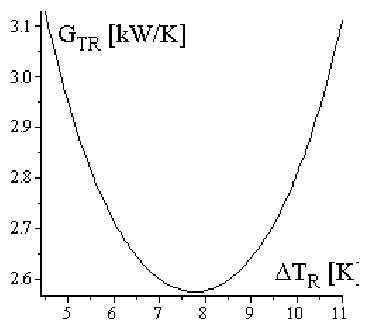
Figure 18. G TE dependence of Δ T H —case “c”. G